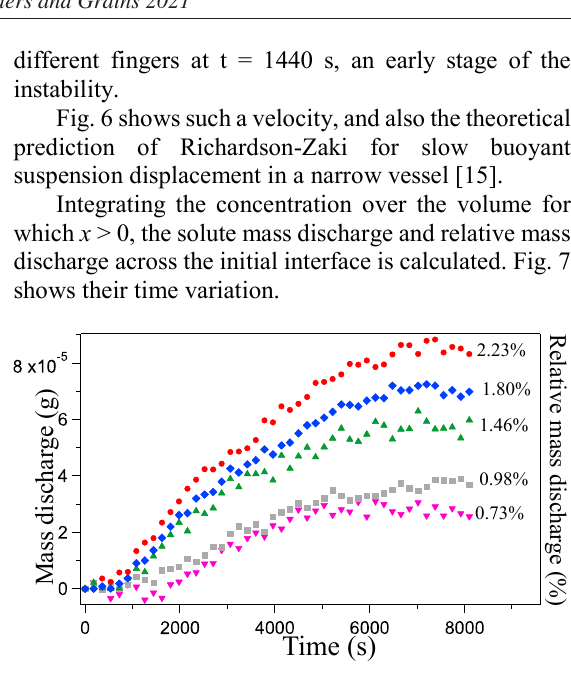
Figure 7. Solute mass discharge and relative mass discharge across the initial interface as a function of time. ( ▼ : ϕ =